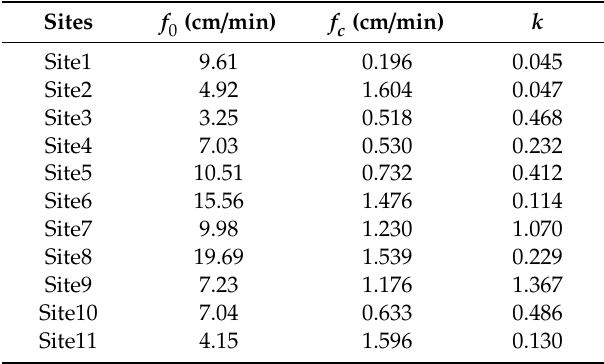
Figure 3. Locations of soil sample sites and cross-sections of Huangshui River. Table 2. The parameters of Horton equation in the study area.